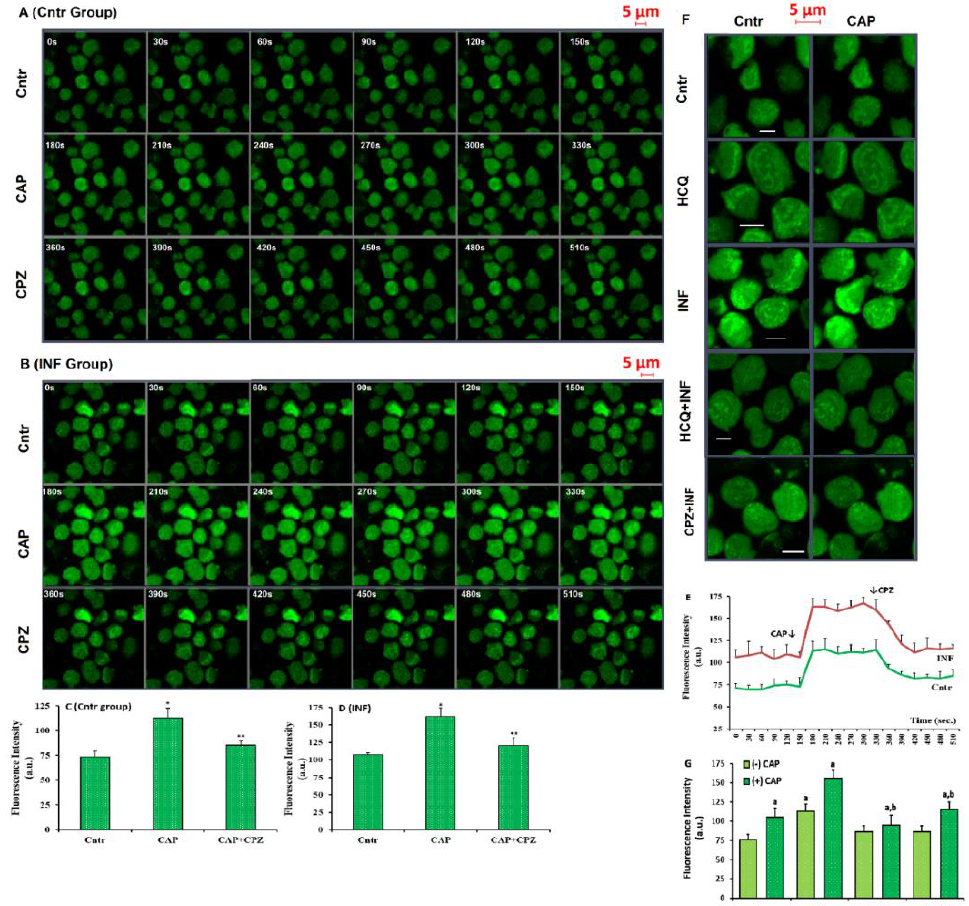
Figure 5. HCQ (60 μM for 16h) modulated acute INF-caused increase of cCa 2+ concentration in the U937 monocytes. (Mean ± SD). The cells were stained with Fluo 3-AM (1 μM for 1h). The monocytes were stimulated by CAP (10 μM for 150s) and then, they were inhibited by CPZ (0.1 mM for 150s) in the confocal microscope (LSM800) with 40× 1.3 oil objective. ( A , B ) Fluo 3-AM imaging and mean Ca 2+ fluorescence intensity (arbitrary unit, a.u.) in the Cntr and INF groups, respectively. The cap- ture time (second) of each image was indicated in the corner of each image by white numbers. ( C , D ) The mean concentrations of Ca 2+ fluorescence intensities were indicated in the ( A , B ) by columns. ( E ) Fluo -3-AM images in the five groups (Cntr, HCQ, INF, HCQ+INF, and CPZ+INF). ( F , G ) The mean column graphics of Ca 2+ fluorescence intensity in the Cntr and INF, respectively. The scale bar was kept as 5 µm. * p ≤ 0.05 vs Cntr. ** p ≤ 0.05 vs INF. a p ≤ 0.05 vs. CAP stimulation (-CAP). b p ≤ 0.05 vs. CAP stimulation (+CAP).